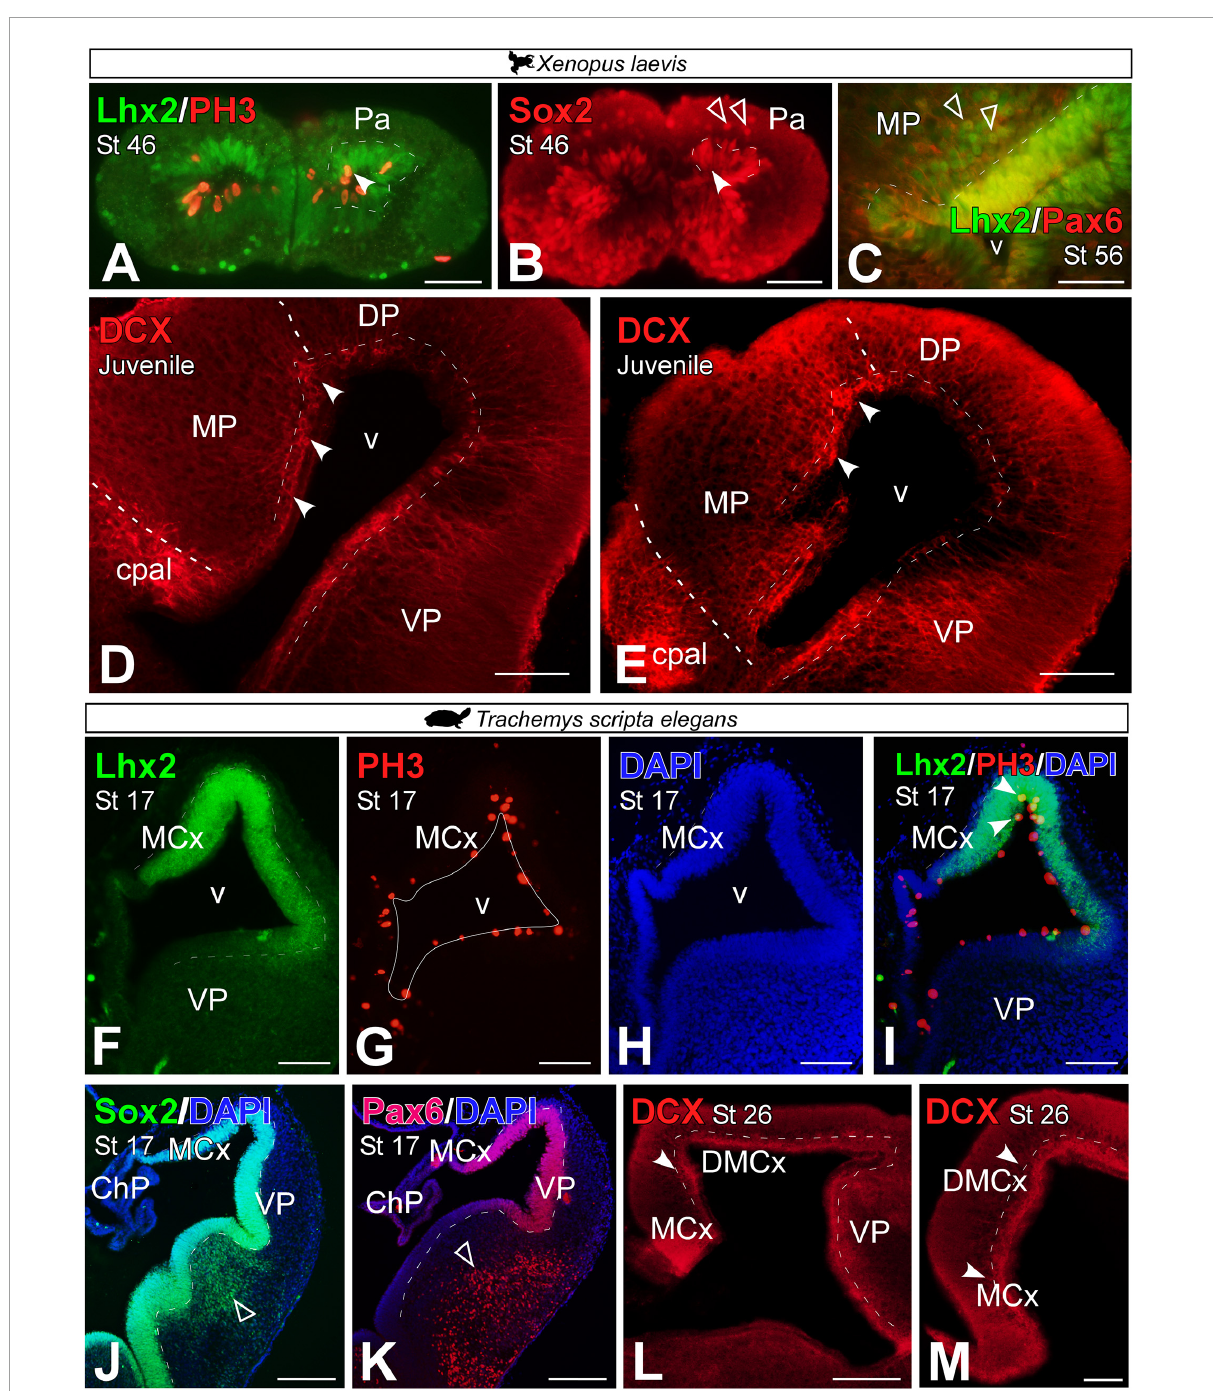
FIGURE5 Photomicrographs of transverse sections through the developing telencephalon of Xenopus laevis (A–E) and Trachemys scripta elegans (F–M) showing the distribution of Lhx2 in combination with PH3, where only double-labeled mitotic cells are observed in the ventricular zone (arrowheads). The progenitor cell marker Sox2 (B,J) is observed in both cases in the ventricular region (filled arrowhead) and in X. laevis at these stages additionally in the mantle (empty arrowhead). The Lhx2 cells are proximal to the ventricle co-expressed Pax6 in the ventricle (filled arrowhead) and out of it [empty arrowheads in panel (C) ]. The neuroblast marker doublecourtine (D,E,L,M) was detected in the ventricular region of the medial pallium in both cases (filled arrowheads). In each panel, the developmental stage and the color code for the used markers are indicated. Filled arrowheads point to ventricle-expressing cells and empty arrowheads to mantle-expressing cells. Scale bar in panels (A,B,D–L) = 200 µ m and (C,M) = 100 µ m. See the abbreviation